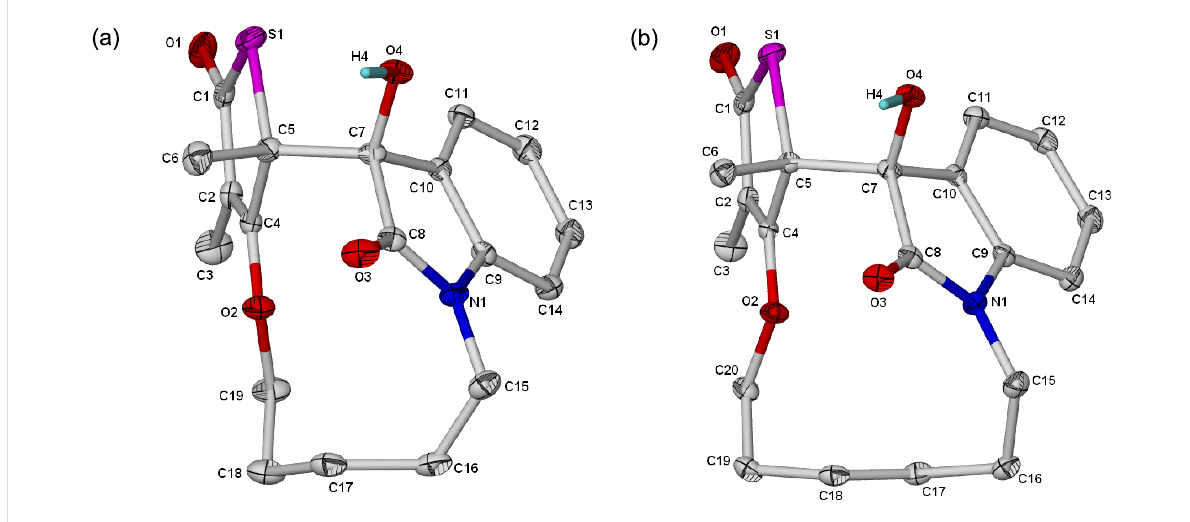
Figure 4: Molecular structure of (a) 4b and (b) 4c , with ellipsoidal model of probability level = 35%.